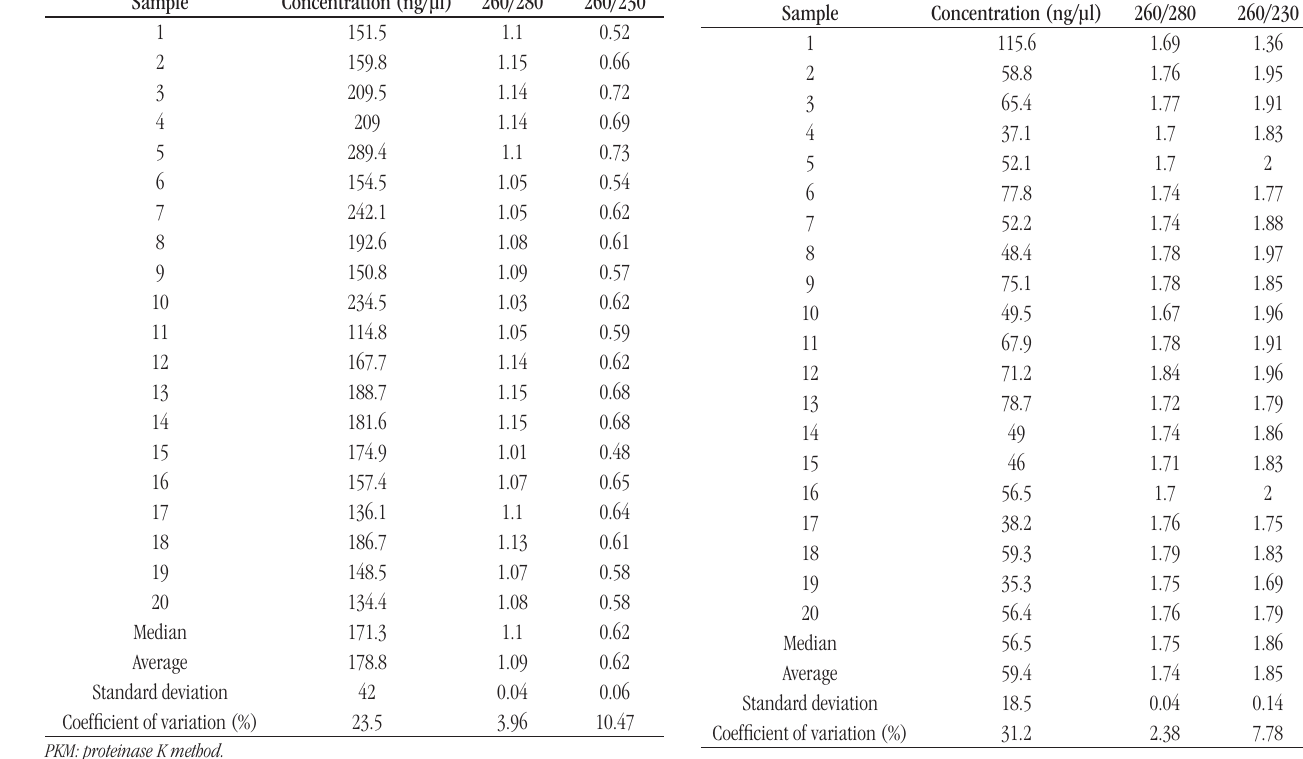
taBLE 2 − Concentration and ratios 260/280 and 260/230 of the samples